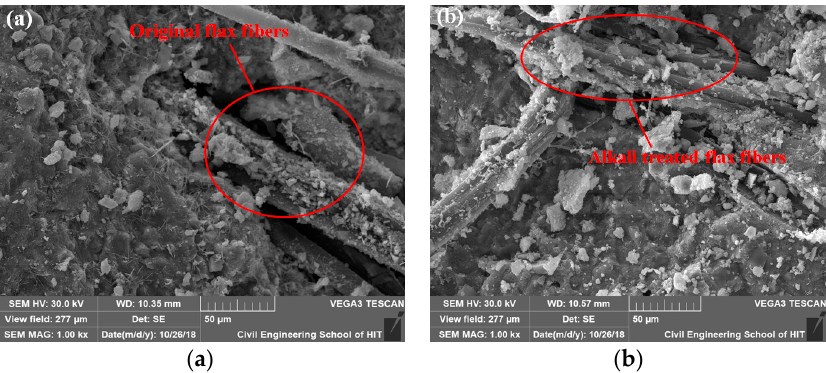
Figure 2. SEM image of cement paste with 0.5 wt %. ( a ) Original flax fiber (F0.5) and ( b ) alkali modified flax fiber (MF0.5) at 1000 × .